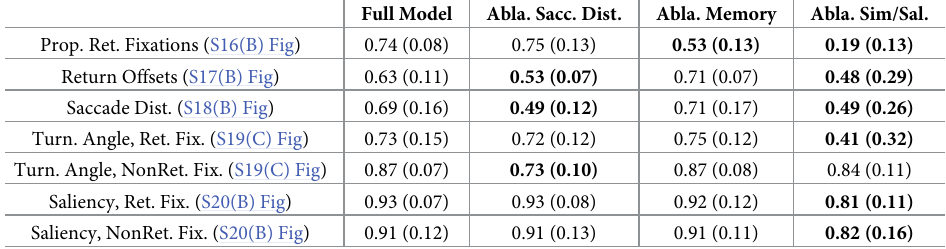
Table 1. Summary of similarity indices for full and ablated versions of the model for multiple properties. Values indicate the mean similarity index (with SD in parentheses) across the six tasks (Human Visual Search 1, 2, and 3, Human Free Viewing, and Monkey Free Viewing 1, and 2). Highlighted in bold are the values that showed large differ- ences with respect to the full model. These results indicate that altering each of the model modules led to worse corre- spondence to the experimental properties of return fixations. For each property, the supplementary figures cited in the first column provide similarity indices for each individual